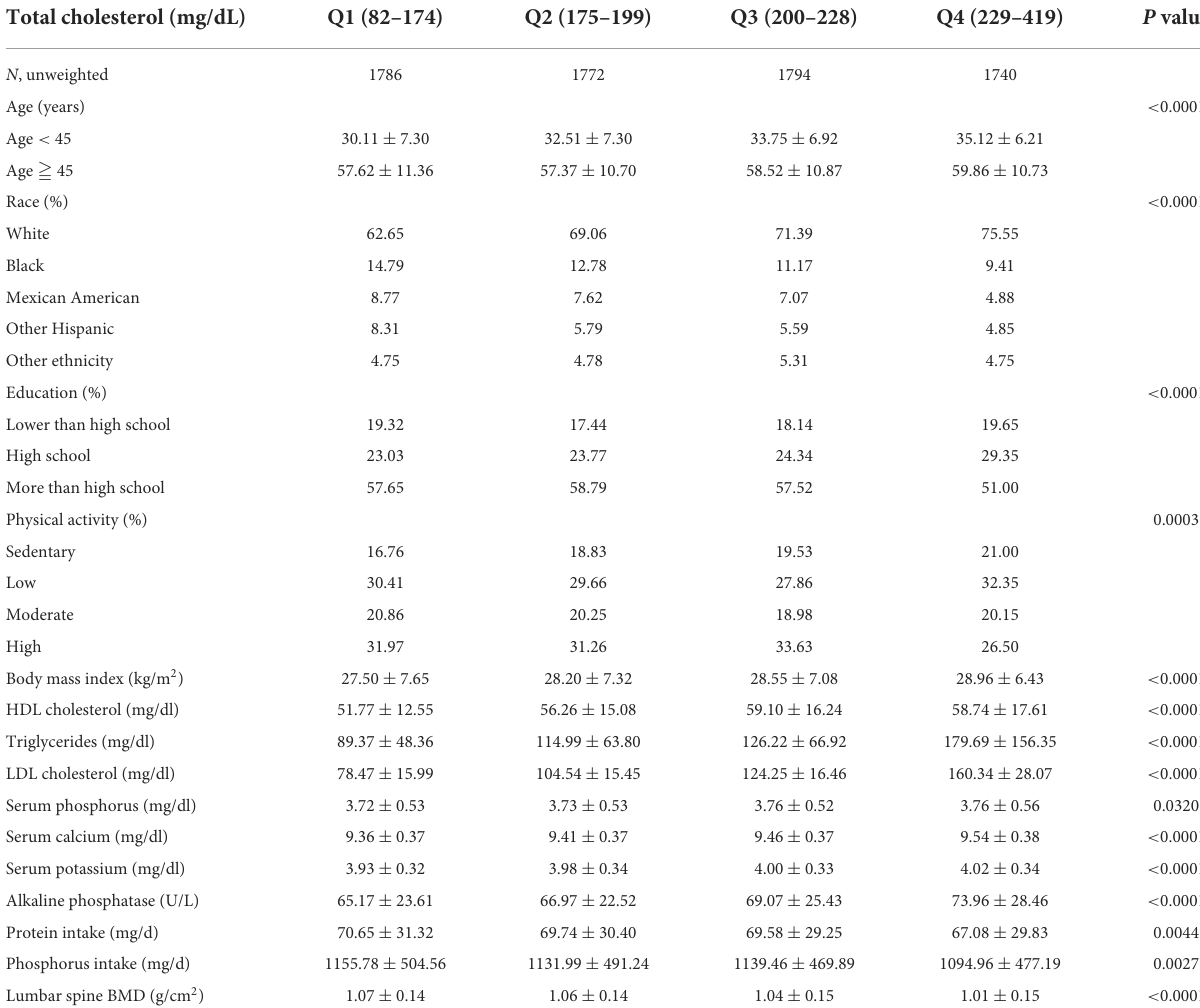
TABLE 1 Weighted characteristics of 7,092 participants included in this study.